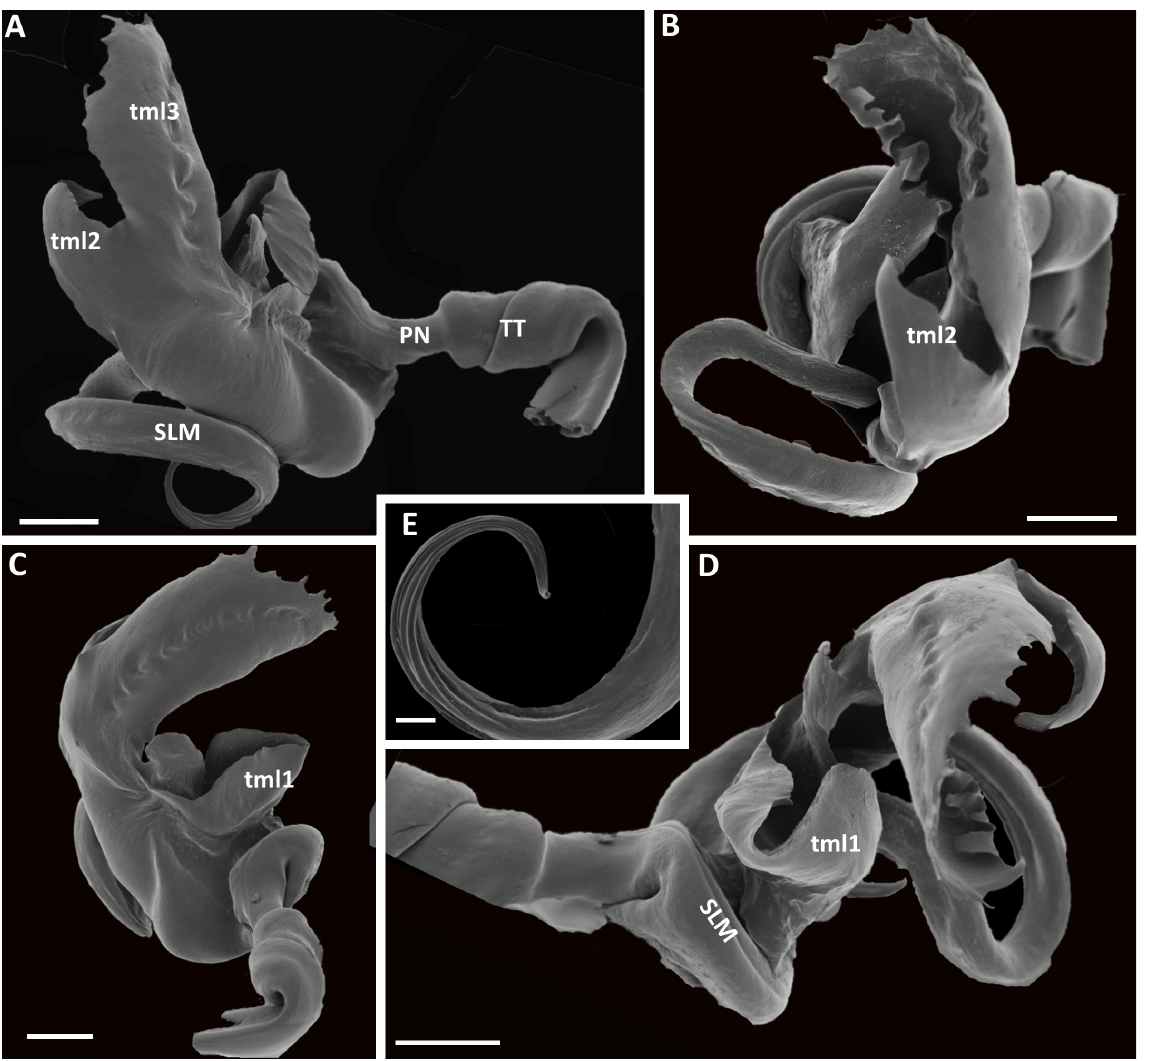
Fig. 27. Chaleponcus nesrineae sp. nov., holotype, ♂ (VMNH110628). Right gonopod telopodite. A . Anterior view. B. Mesal view. C . Posterior view. D . Lateral view. E . Tip of solenomere. Abbreviations: PN = post-torsal narrowing; SLM = solenomere; tml = telomeral lamellae (numbered); TT = torsotope. Scale bars: A–D = 0.2 mm; E = 0.05